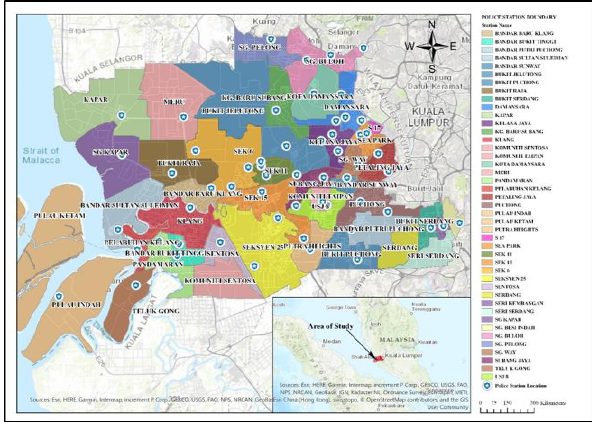
Figure 1: The study